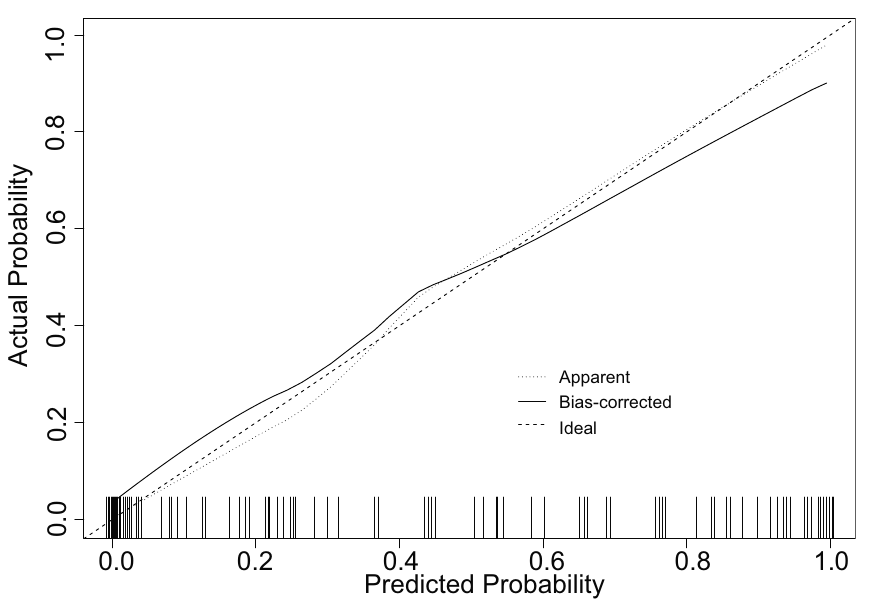
Figure 3. 1000-bootstrap resampling internal verification correction for a nomogram of breast pathologic complete response rates after neoadjuvant chemotherapy in breast cancer patients with multiple